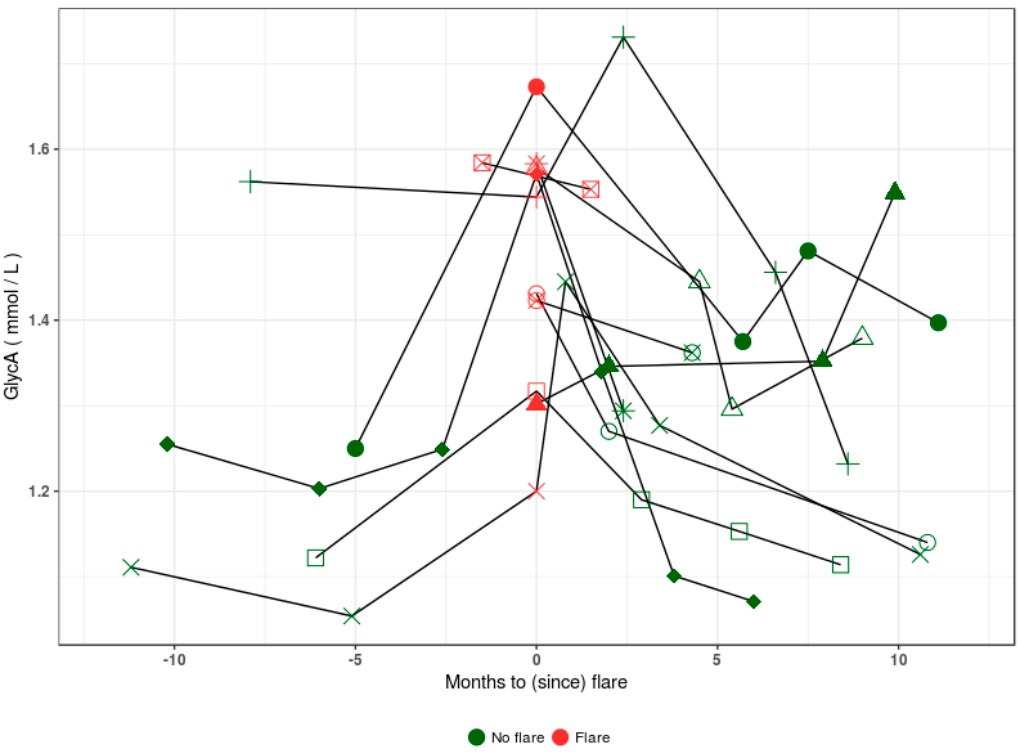
Figure 3. GlycA levels in longitudinal samples of 11 patients with lupus nephritis who were sampled longitudinally and at the time of a flare. In samples taken up to a year prior and after the flare event, patients show increased GlycA levels at or directly following flare presentation (red). Post flare, most patients show a return to baseline GlycA levels.